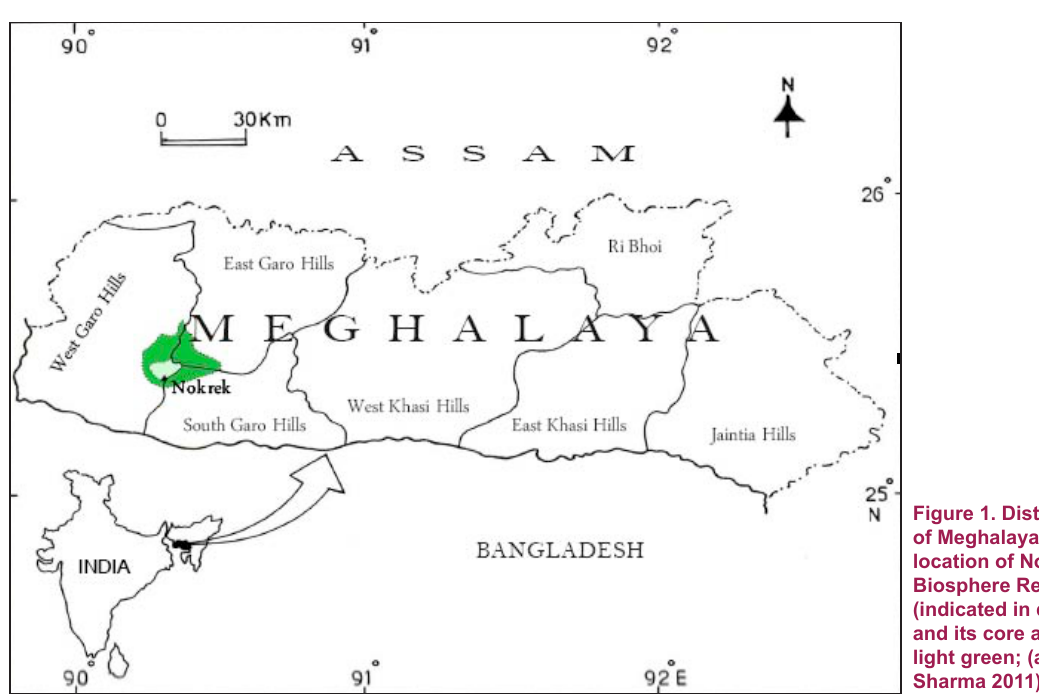
Figure 1. District map of Meghalaya showing location of Nokrek Biosphere Reserve (indicated in dark green) and its core area shown in light green; (after Sharma & Sharma